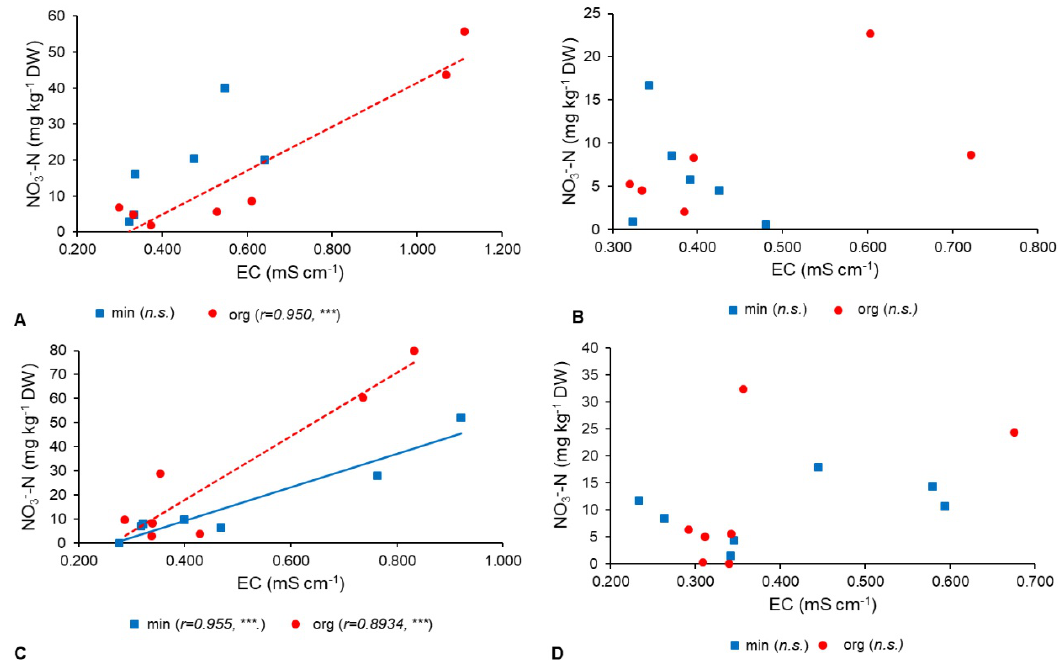
Figure 4. Correlation between electric conductivity (EC) measured by probes and soil nitrate (NO 3 − )-N concentration in organic and mineral fertilized plots in April ( A ), May ( B ), June ( C ) and August ( D ). ***, n.s. = effect of treatment significant at p ≤ 0.001 or not significant , respectively